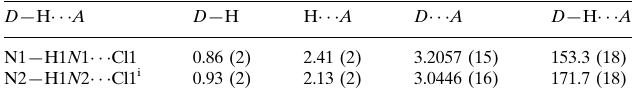
Hydrogen-bond geometry (A˚ , (cid:3)